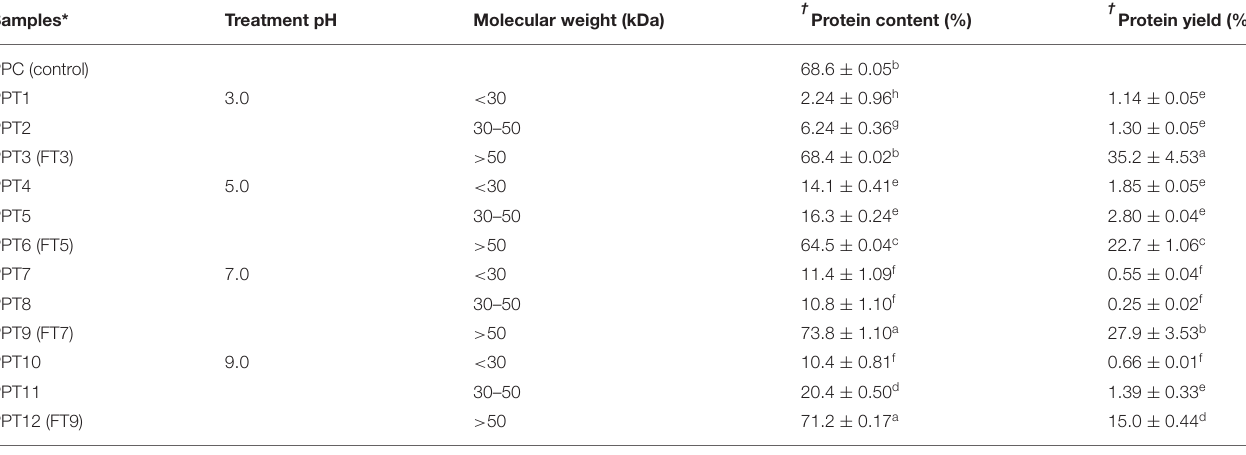
TABLE 1 | Protein content and yield of > 50 kDa pea protein aggregates isolated by membrane ultrafiltration after heat treatment (100 ◦ C) at different pH values. Samples*